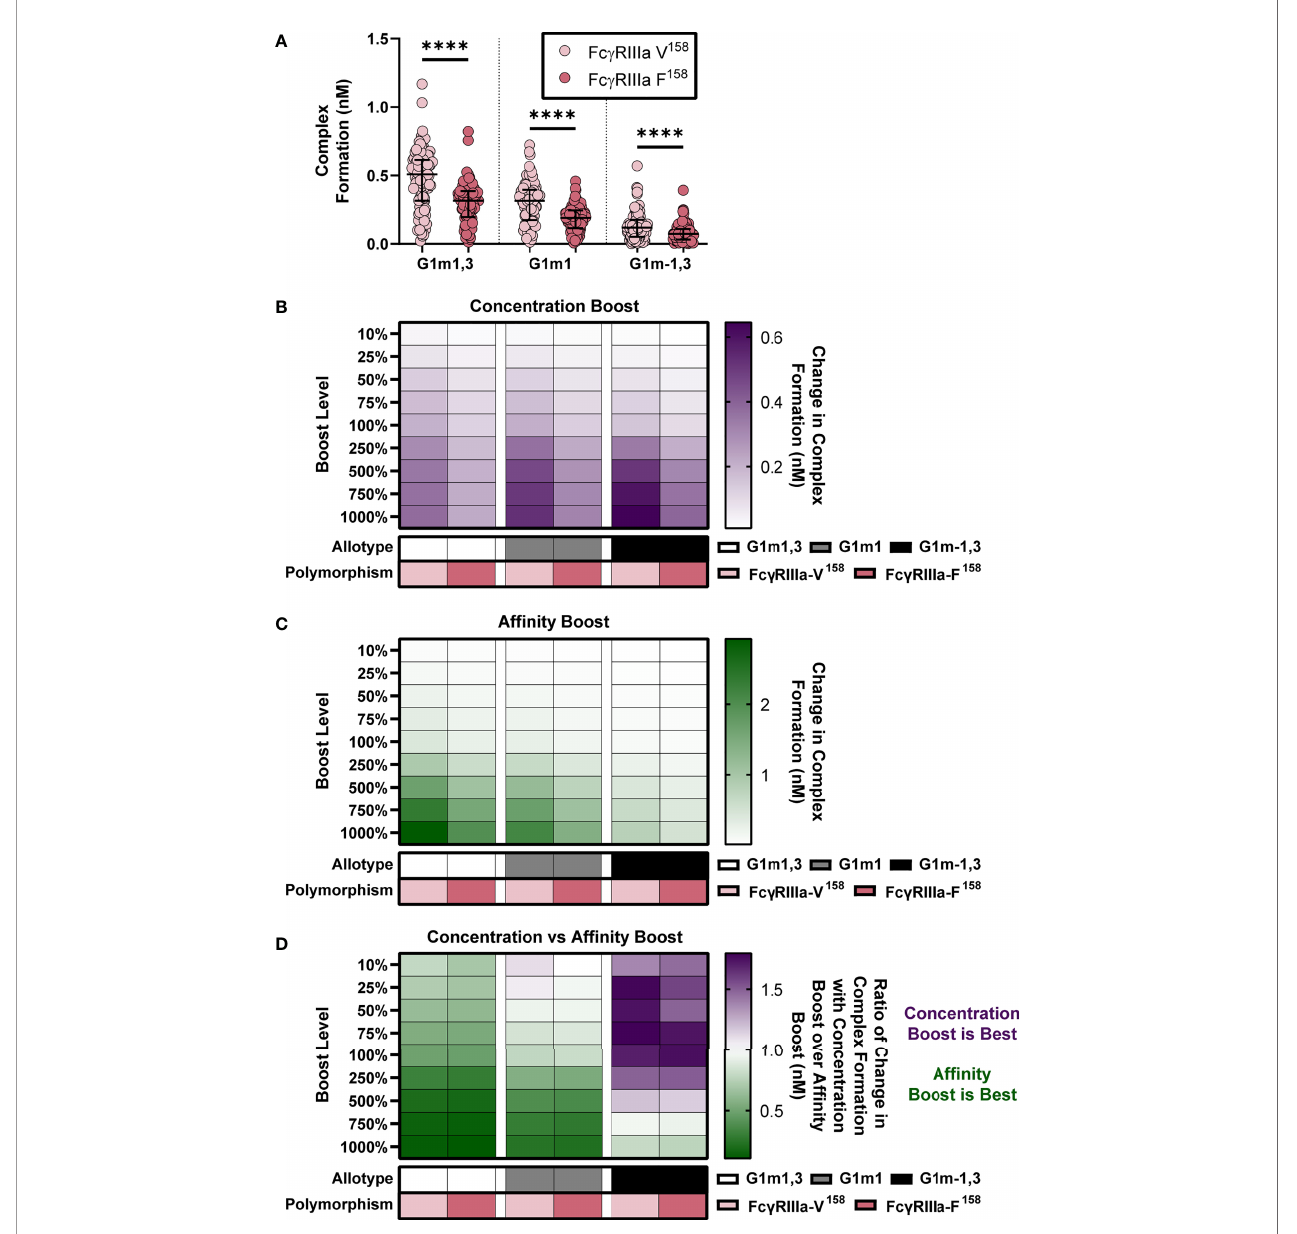
FIGURE 5 | IgG1 allotype determines whether boosting IgG1 concentration or boosting IgG1 af fi nity (k on IgG1- Fc g R) would be most effective for increasing complex formation. (A) Model predictions for complex formation of RV144 vaccinees (n=105) in two Fc g RIIIa polymorphisms, Fc g RIIIa-V 158 (light pink) and Fc g RIIIa-F 158 (dark pink), and three IgG1 allotypes, G1m1,3 (original RV144 data), G1m1 and G1m-1,3. Polymorphisms were simulated by altering the binding af fi nities of each IgG subtype to Fc g R as previously published (11) and indicated in Figure 3A . Allotypes are simulated by multiplying each vaccinee ’ s IgG1, IgG2, IgG3 and IgG4 initial concentration by its respective conversion factor as previously published (29) and indicated in Figure 4A (Friedman test with Dunn ’ s multiple comparisons test comparing the two polymorphisms within each allotype; ****p-value < 0.001). (B) Simulated IgG1 concentration boosting in each allotype (G1m1,3, white; G1m1, gray; G1m-1,3 black) and polymorphism (Fc g RIIIa-V 158 , light pink; Fc g RIIIa-F 158 , dark pink) combination. Boosts were calculated by multiplying the individual ’ s baseline initial IgG1 concentration value by the boost levels and then this was added on top of each individual ’ s baseline. (B) Color indicates median change in complex formation for each genetic background. (C) Simulated boosting of k on IgG1- Fc g R in each allotype (G1m1,3, white; G1m1, gray; G1m-1,3 black) and polymorphism (Fc g RIIIa-V 158 , light pink; Fc g RIIIa-F 158 , dark pink) combination. Boosts were calculated by multiplying the individual ’ s baseline k on IgG1- Fc g R value by the boost levels and then this was added on top of each individual ’ s baseline. Color indicates median change in complex formation for each genetic background and boost as indicated. (D) The ratio of median change in complex formation with a boost in IgG1 concentration over median change in complex formation with a boost in k on IgG1-Fc g R (af fi nity) at each boosting level. This ratio shows which type of boost is most effective for increasing complex formation (IgG1 concentration, purple; k on IgG1-Fc g R, green) and when both are equally bene fi cial